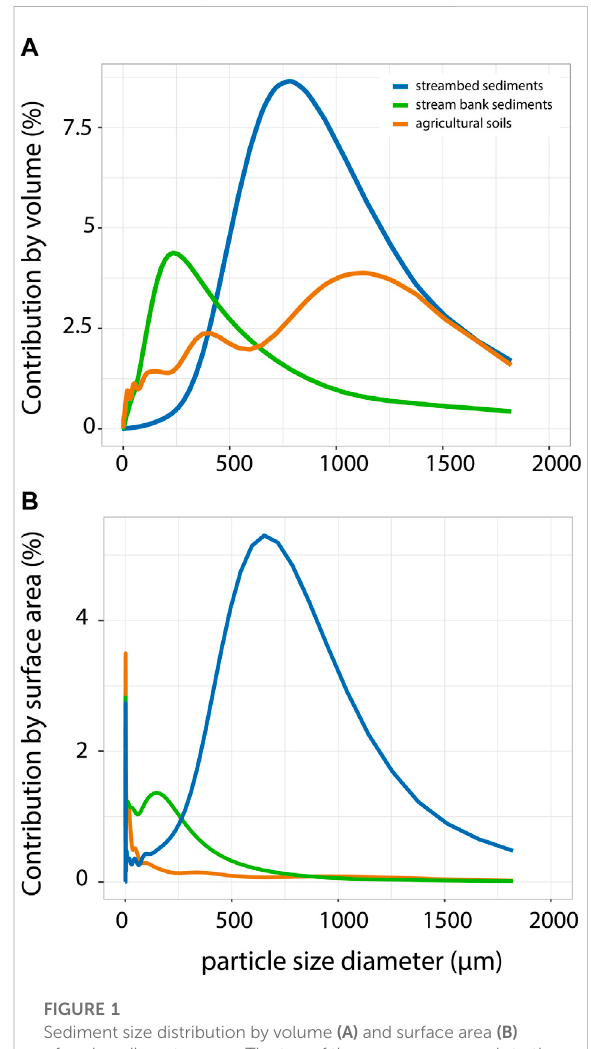
FIGURE 1 Sediment size distribution by volume (A) and surface area (B) of each sediment source. The top of the curve corresponds to the medianparticlediameterorsurfacearea,forwhichthepercentage ofparticleswithdiametersorareasmallerandlarger thanthis are